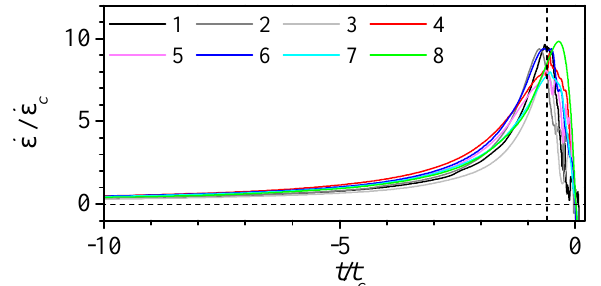
Figure 8. Dimensionless strain rate along the nozzle axis versus the dimensionless time to reach the neck for Q = 5 µ L/min. The colour indicates the nozzle number in Table